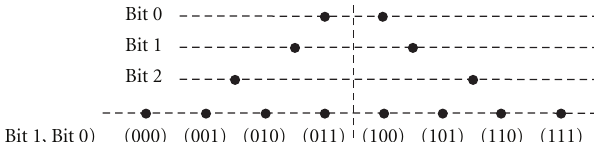
Figure 1: Pulse-amplitude modulation as superposition of binary antipodal modulation with geometric power